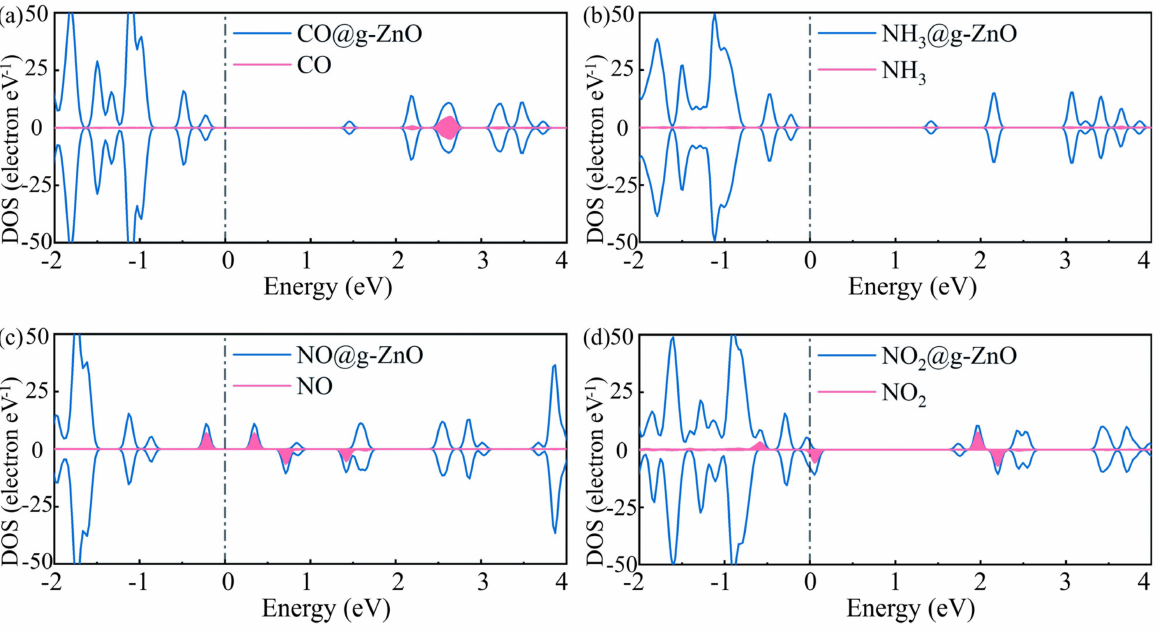
Figure 7. The DOS of ( a ) CO, ( b ) NH 3 , ( c ) NO, or ( d ) NO 2 adsorbed on intrinsic g − ZnO systems. The Fermi level is shifted to 0 eV and respected by a black dash